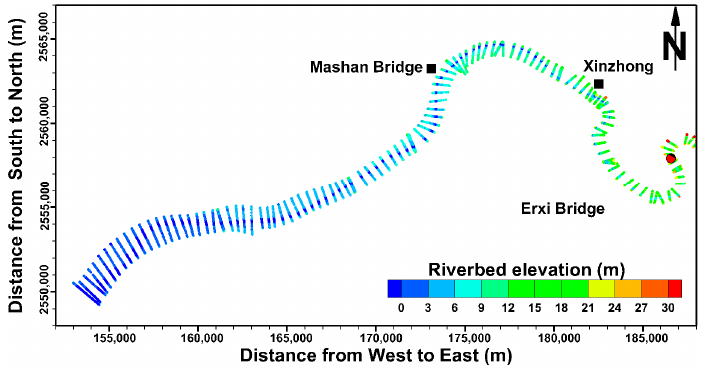
Figure 3. Distribution of the river bed elevation for the original cross section.